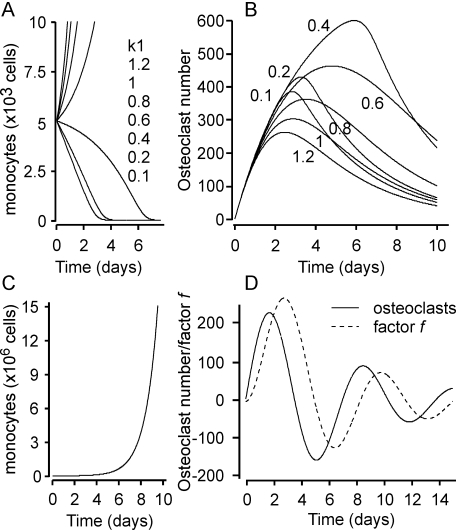
Dynamics of changes in monocyte and osteoclast numbers predicted by the mathematical model.A, B) Simulation of changes in monocyte number (A) and osteoclast number (B) obtained using the two-species model described by the equations (4–5), with the following parameters: k
1 = 0.2; 0.4; 0.6; 0.8; 1; 1.2; k
3 = 0.1; k
5 = 300; k
6 = 0; k
8 = 0.3; n = 8. C, D) Simulation of changes in monocyte number (C) and osteoclast number (D) obtained using the three-species model described by the equations (7–9), with the following parameters: k
1 = 1; k
3 = 0.1; k
5 = 300; k
6 = 0.5; k
8 = 0.3; k
9 = 1; k
10 = 1; k
11 = 0.5; n = 8